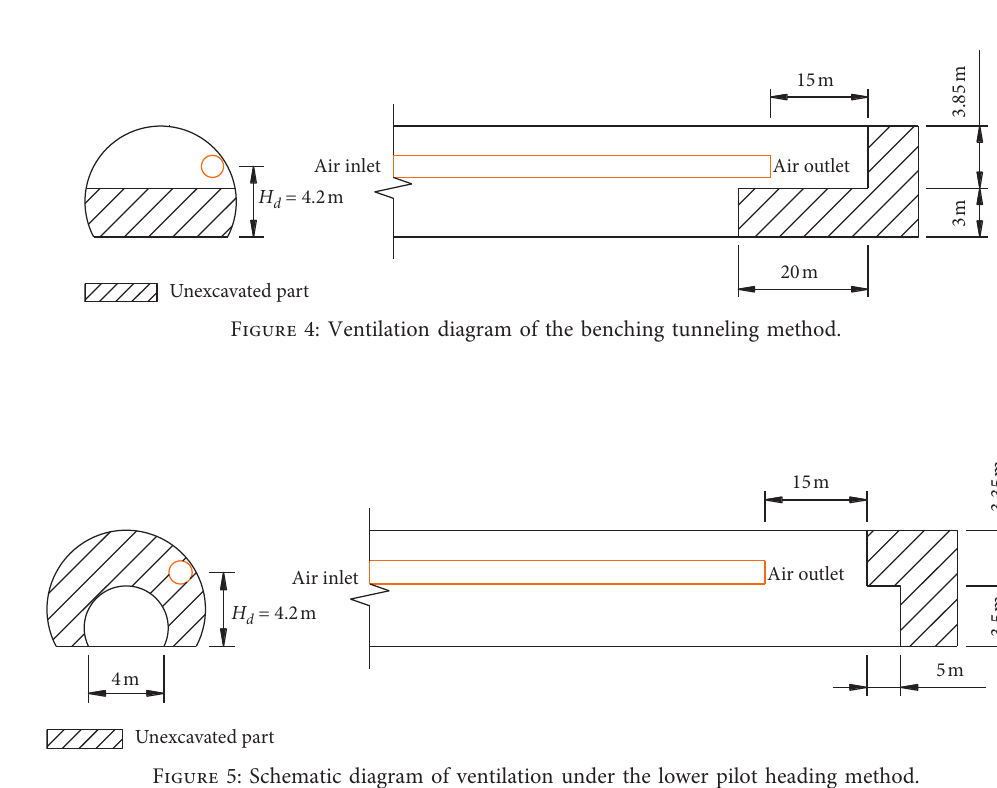
Figure 3: Indication of simulated cross section and longitudinal section for air pipe layout. (a) Cross section. (b) Longitudinal